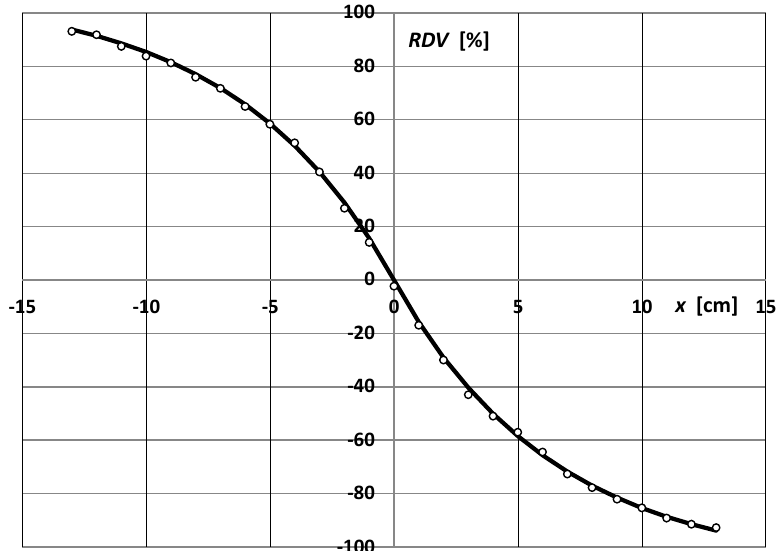
Figure 7. The pulse generated in the spark gap used to calibrate the system of two sensors.